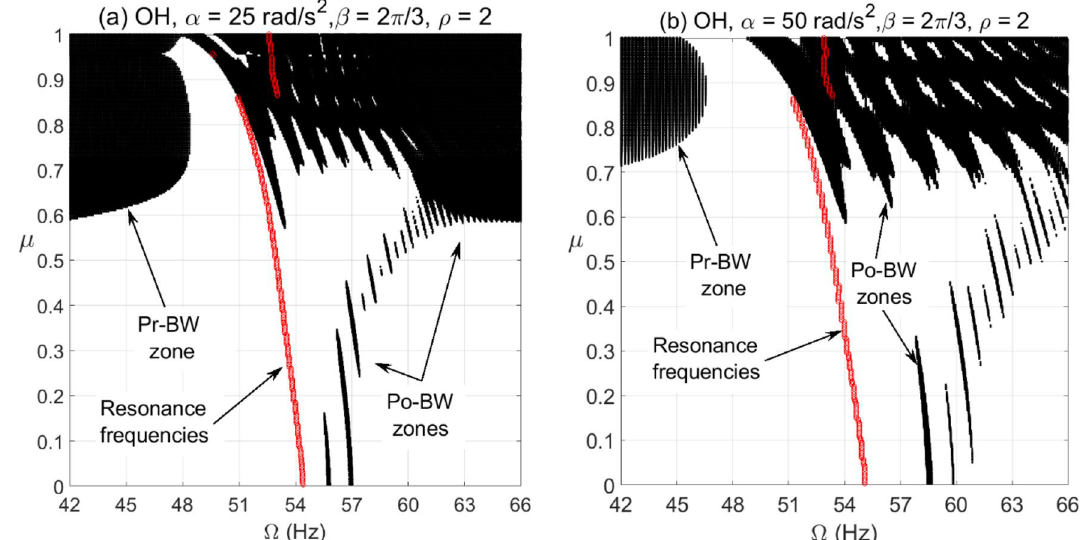
Figure 7. BW zones of rotational speeds at varying normalized crack depths of overhung cracked rotor system 2 in ( a ) at α = 25 rad/s and in ( b ) at α = 50 rad/s